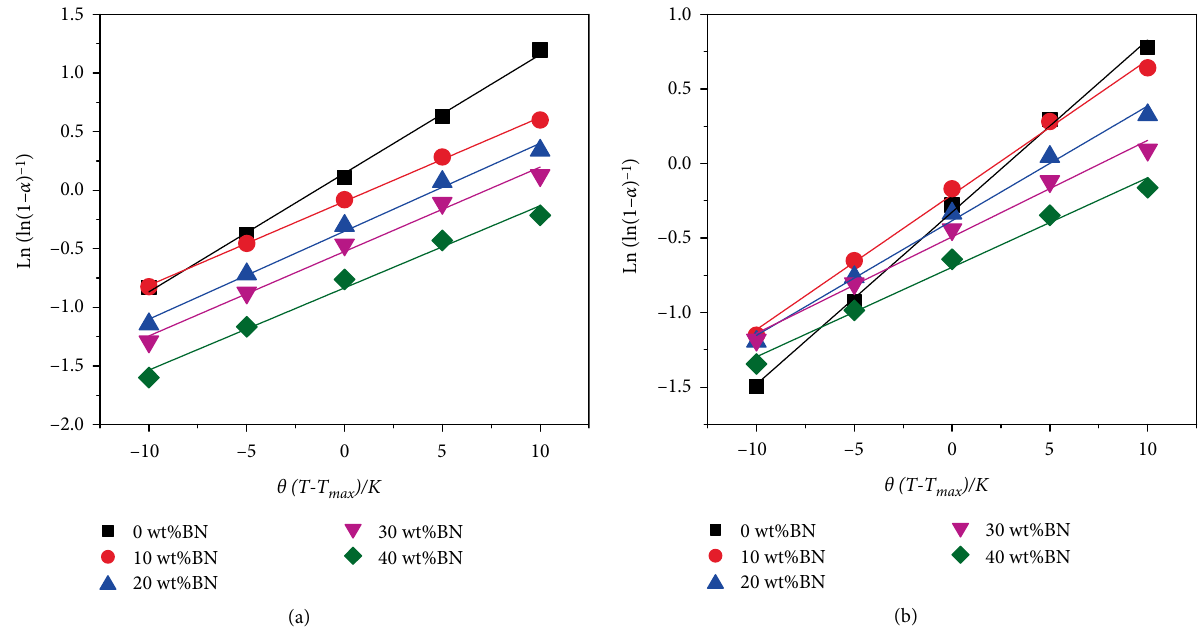
Figure 6: The plots of ln ( ln (1 − 𝛼) −1 ) versus 𝜃 as shown for the UHMWPE/BN composites by solvent mixing (a) and melt mixing (b).